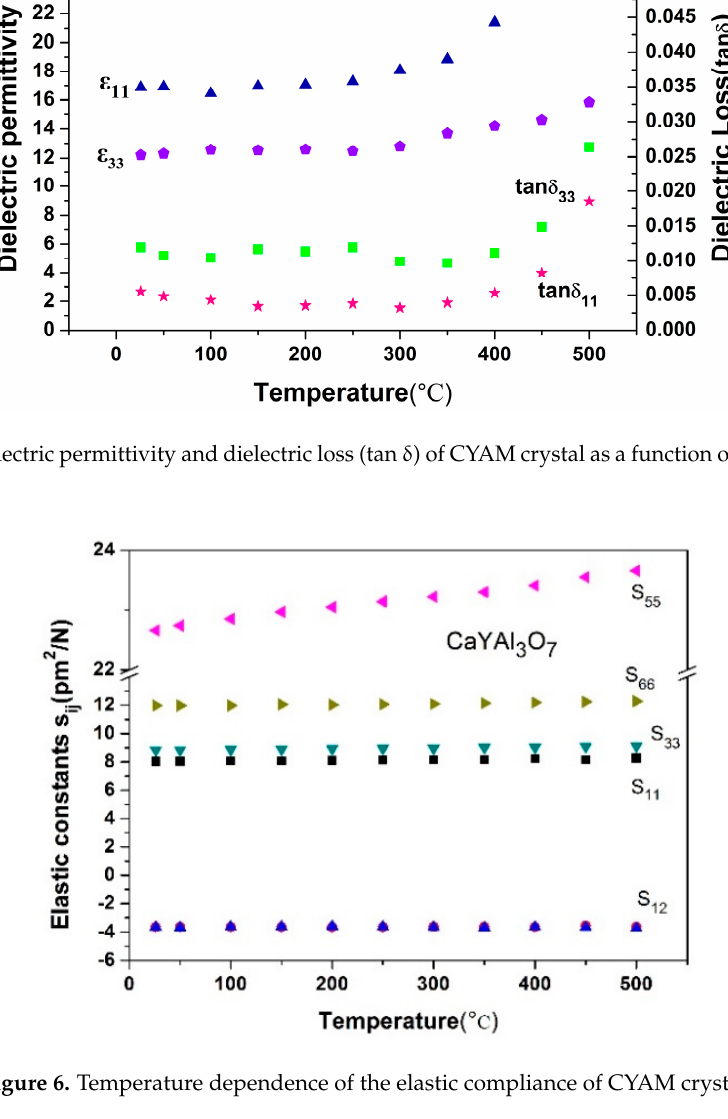
Figure 6 Temperature dependence of the elastic compliance of CYAM crystal. Table 3. First-, Second-, and Third-Order Temperature Coefficients of the Elastic Constants. Ts